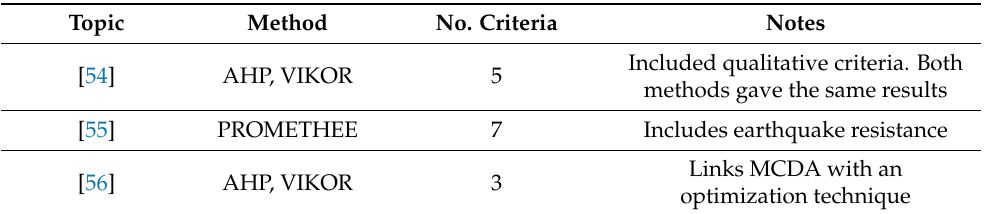
Table 6. Examples of MCDA applications in Bridge Design